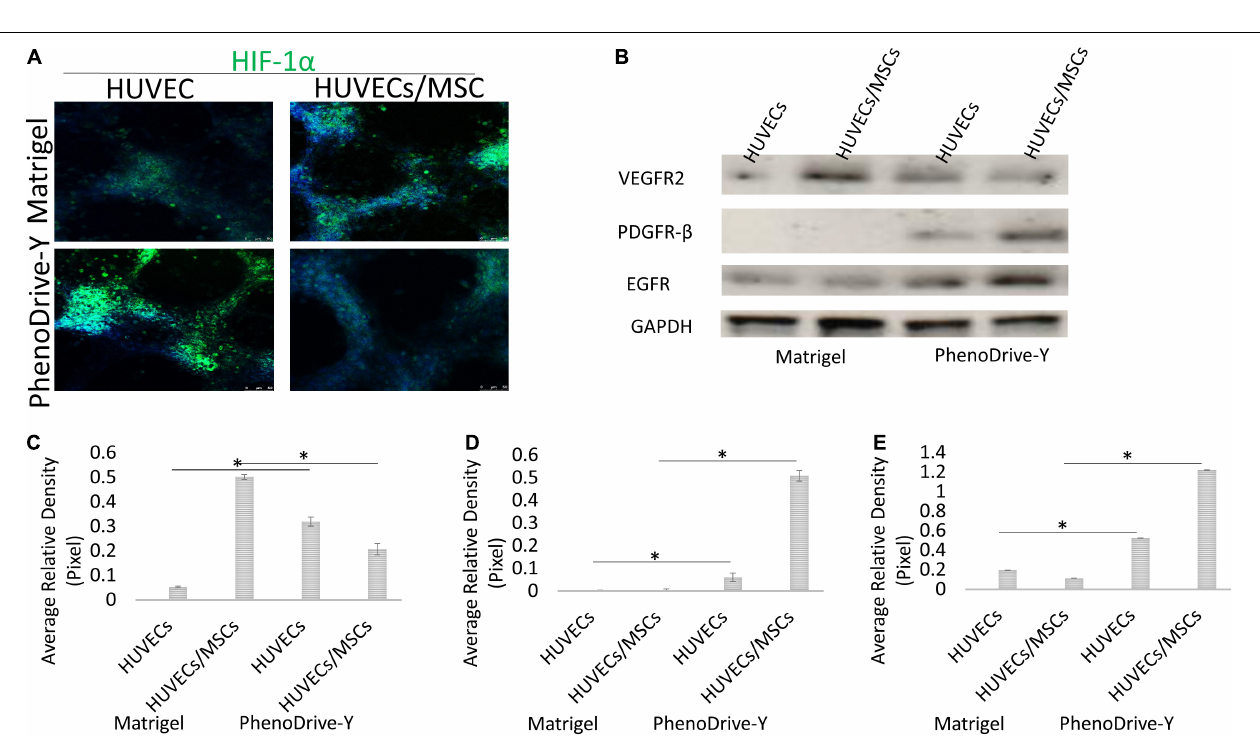
FIGURE 7 | (A,B) Expression of HIF-1 α (A) and specific pro-angiogenic cues (B) within cells grown of distinct matrices at 48 h. (C–E) The expressions of VEGFR2 (C) , PDGFR- β (D) , and EGFR (E) were assessed and normalized against the GAPDH positive control * p ≤ 0.001.